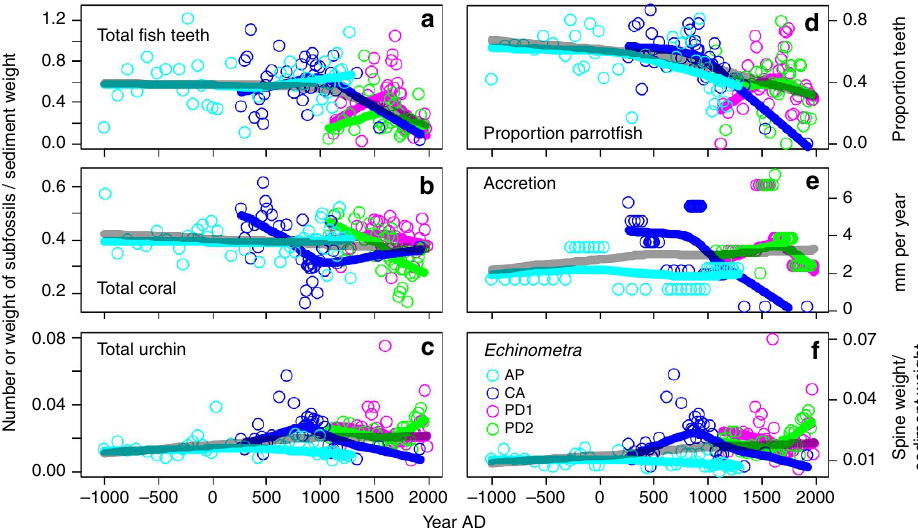
Figure 3 | Millennial-scale trends in abundance of major reef subfossil groups and accretion rates. ( a ) Total fish tooth abundance measured as number of individual teeth divided by dry weight of all sediment size fractions combined. ( b ) Total coral abundance measured as weight of coral fragments from 4 2mm sediment fraction divided by dry weight of 4 2mm fraction. ( c ) Total urchin abundance measured as weight of urchin spines divided by dry weight of 0.5–2mm sediment fraction. ( d ) Proportion of all teeth belonging to parrotfish. ( e ) Reef accretion rate represented as mm of reef sediment accumulated per year. ( f ) Abundance of Echinometra urchins measured as total spine weight of genus divided by dry weight of 0.5–2mm sediment fraction. Number samples ¼ 154. Turquoise ¼ Airport Point, blue ¼ Cayo Adriana, pink and green ¼ Punta Donato 1 and 2, respectively. Coloured lines are loess smoothed estimated trends for individual cores and semitransparent black lines are loess smoothed estimates for all cores combined; smoothing parameter ¼ 0.9.